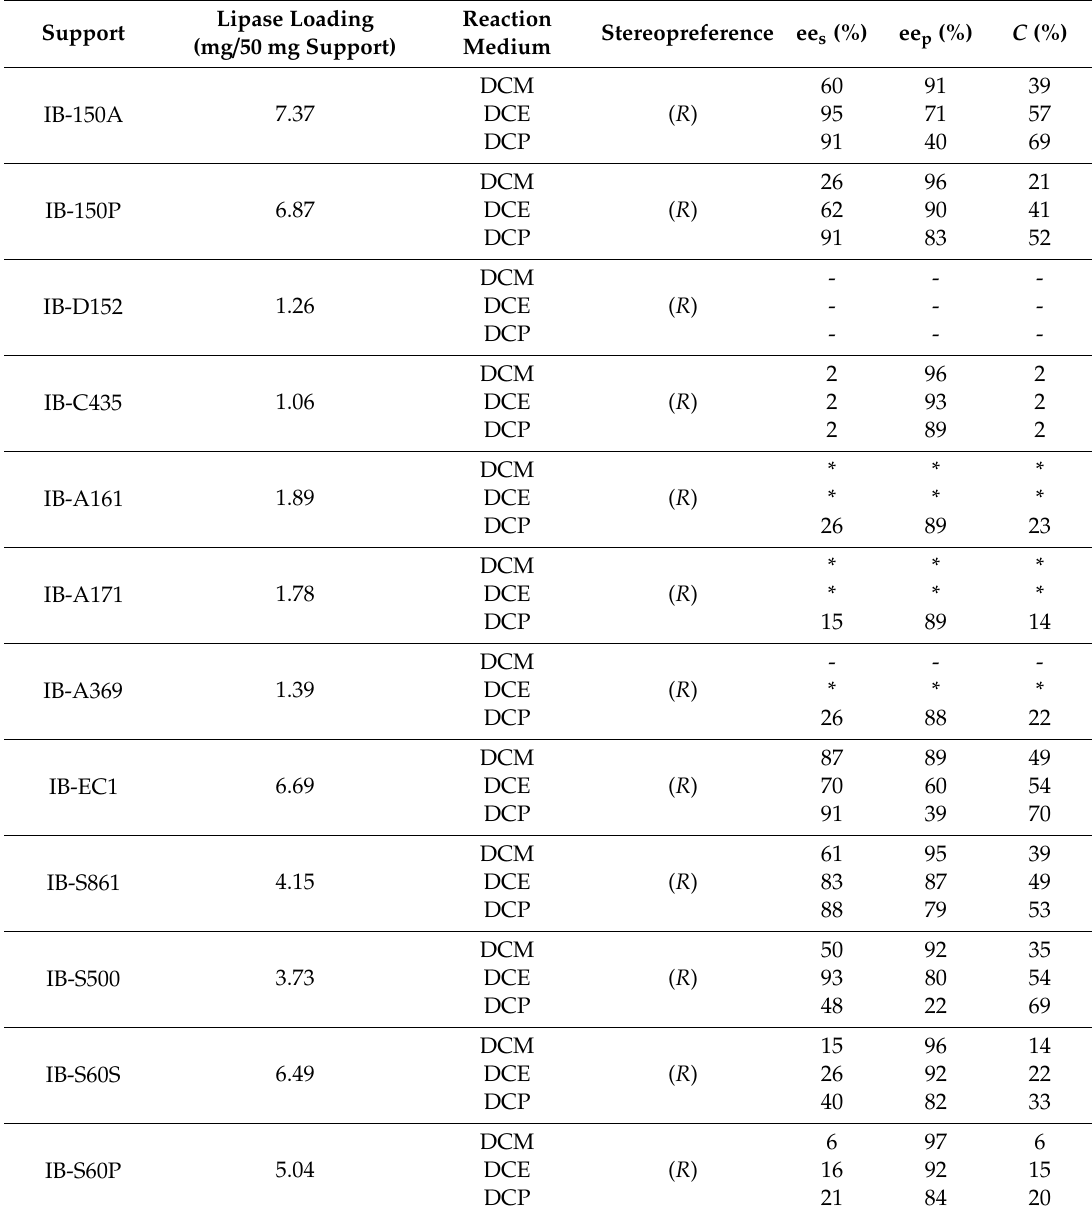
Table 2. The e ff ects of supports and reaction media on the parameters of kinetic resolution of ( R , S )-flurbiprofen, after 46 h (1,2-dichloroethane (DCE) and 1,2-dichloropropane (DCP)) and 94 h (dichloromethane (DCM)) of